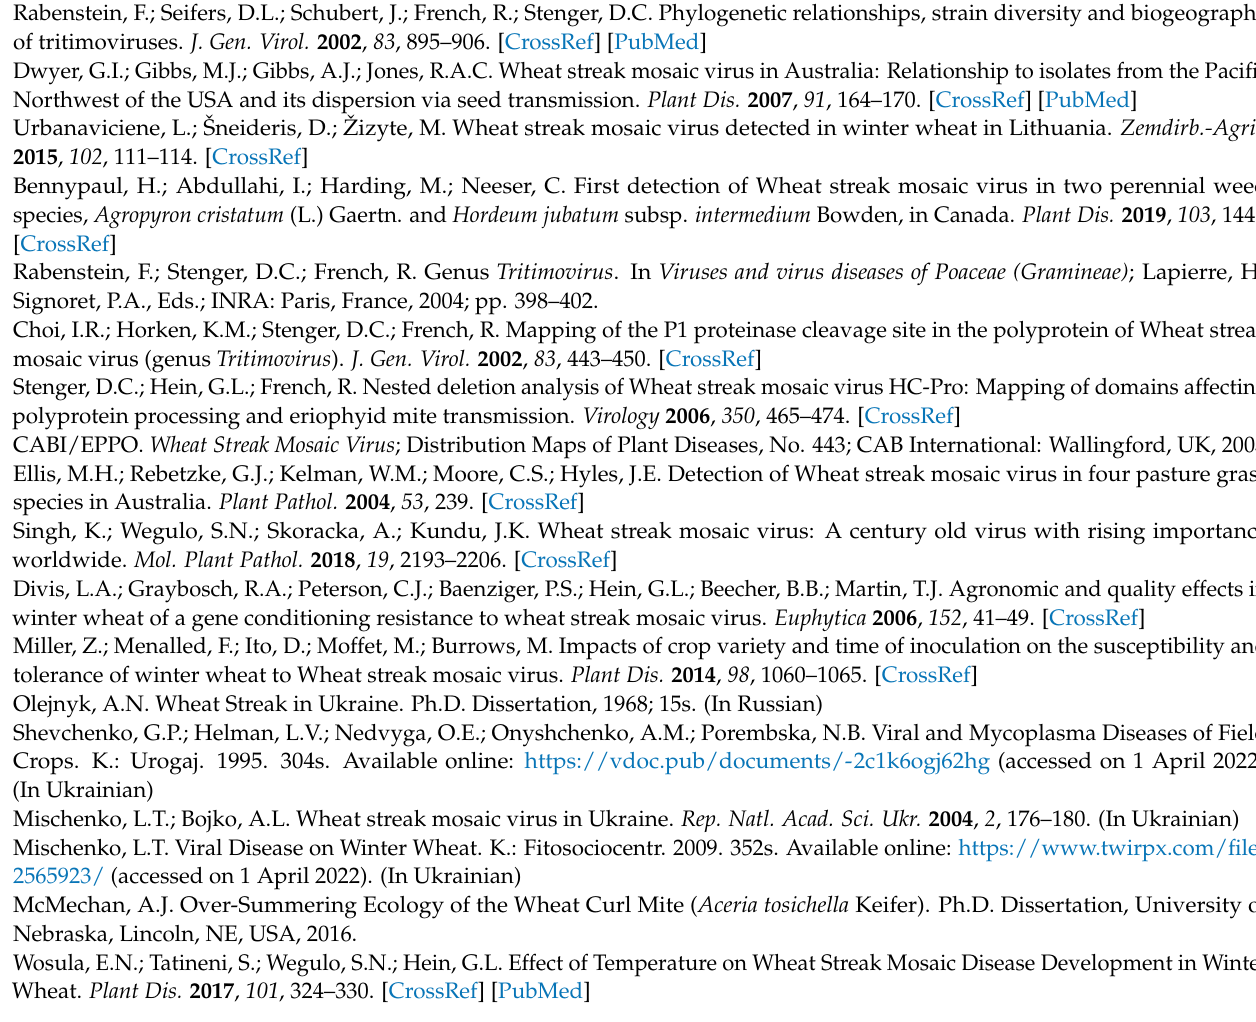
Table S3: Nucleotide and amino acid identity of HPWMoV isolates described in this research (shown in bold) with other HPWMoV